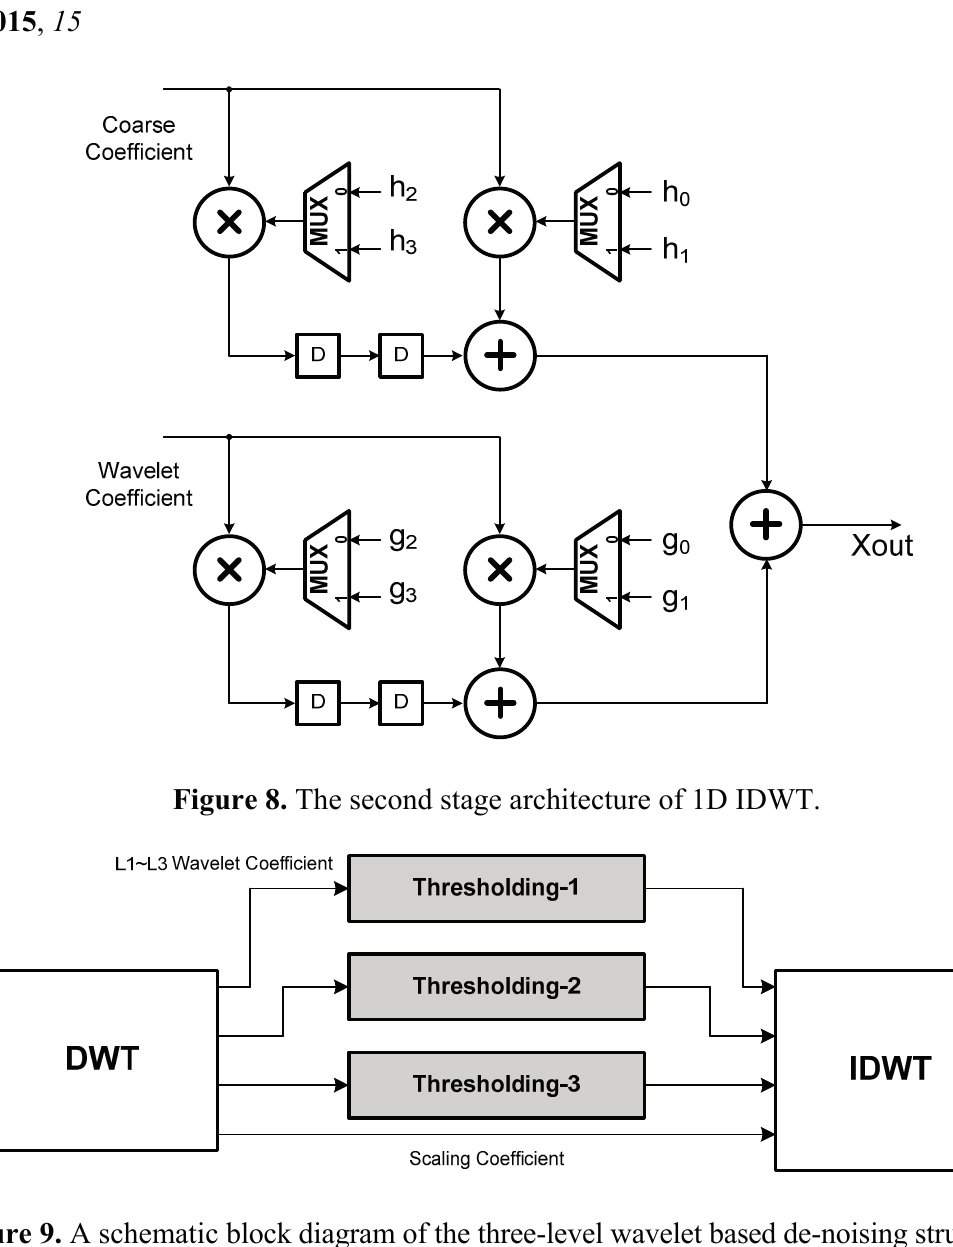
Figure 9. A schematic block diagram of the three-level wavelet based de-noising